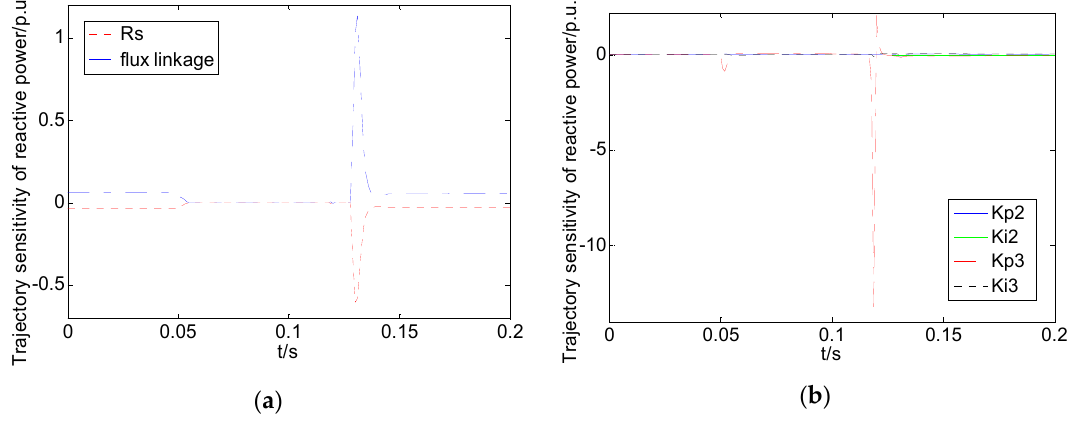
Figure 2. Trajectory sensitivity of active power when voltage dips about 30%: ( a )Trajectory sensitivity of active power for